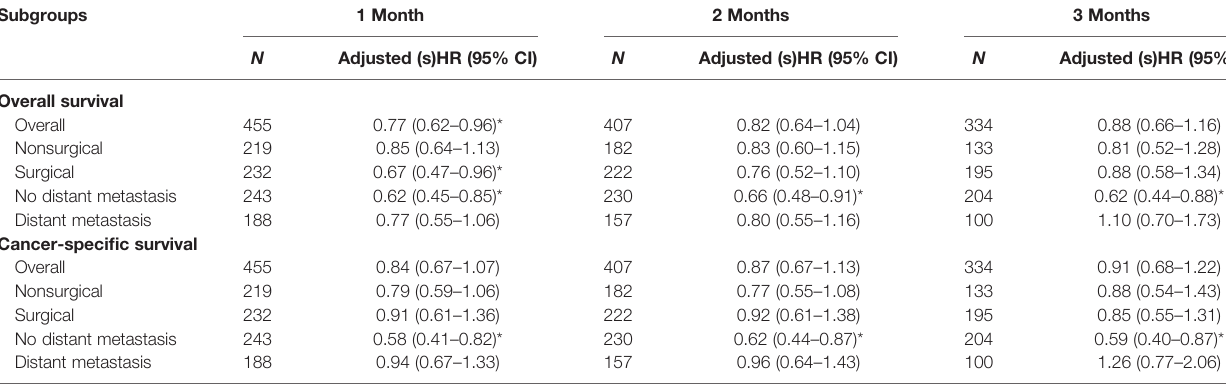
TABLE 4 | Adjusted (subdistribution) hazard ratios of RCT versus RT overall and within each subgroup by surgical resection and distant metastasis after the inverse- probability weighting in the landmark analysis at cutoffs of 1, 2, and 3 months.